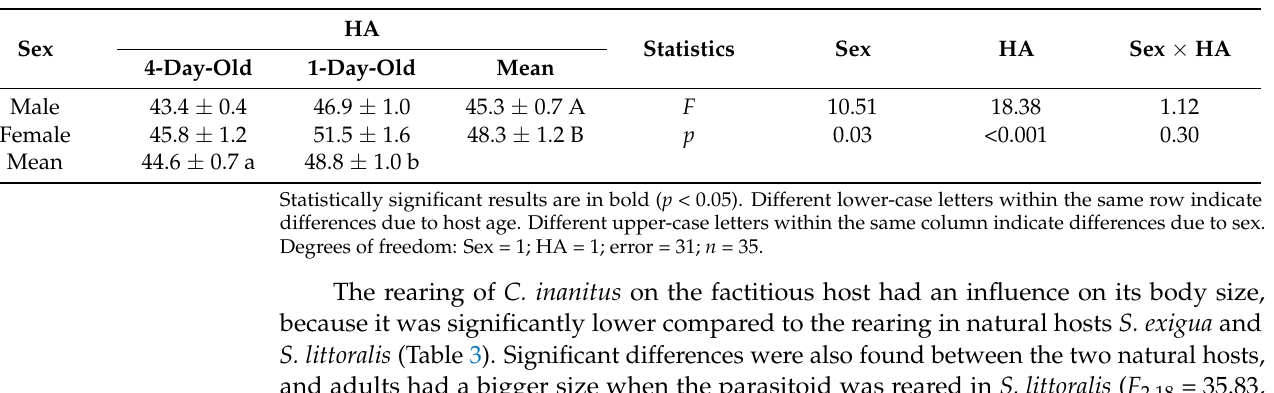
Table 2. Influence of the parasitoid sex and host age (HA) on the developmental time (days)